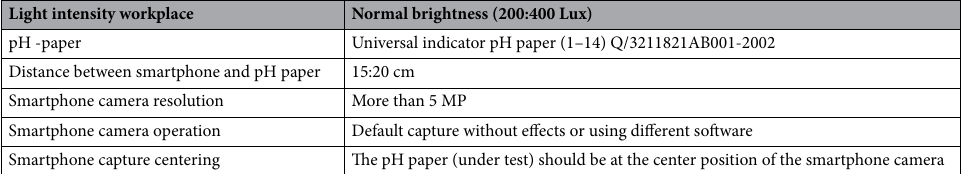
Table 4. Recommended mesurment conditions for application